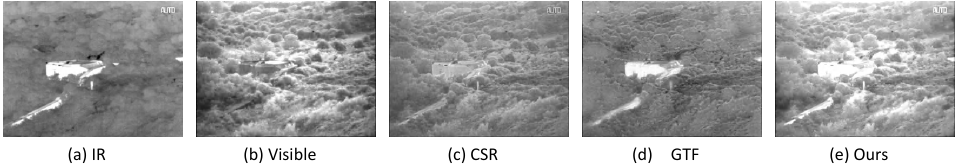
Figure 1. An example of the infrared (IR) and visible image fusion on ‘Bunker’ from the TNO dataset. From left to right: ( a ) IR image, ( b ) visible image, and ( c ) the fusion results by CSR [14], ( d ) GTF [15], and ( e ) our method,